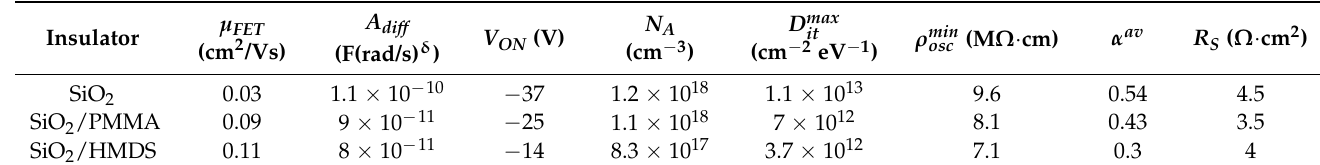
Table 1. Model parameters extracted for OTFTs in BG configuration on different insulator layers.